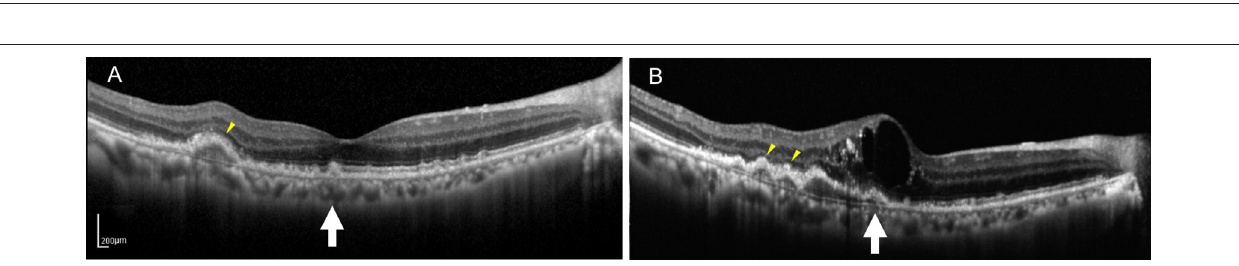
FIGURE 1 | (A) Spectral-domain optical coherence tomography (SD-OCT) image of a 64-year-old female dry patient with age-related macular degeneration (AMD) showing the medium-reflectivity drusen without the retinal pigment epithelium (RPE) or ellipsoid zone (EZ) damage at the fovea. (B) SD-OCT image of the same patient 1.5 years later, demonstrating the notable changes in the fovea, including retinal neuroepithelial hemorrhagic detachment with the local RPE and EZ disruption, which were associated with choroidal neovascularization (CNV). Note that the detected drusen (white arrow) developed into the low-reflectivity fusion drusen corresponding to the presence of the above changes.